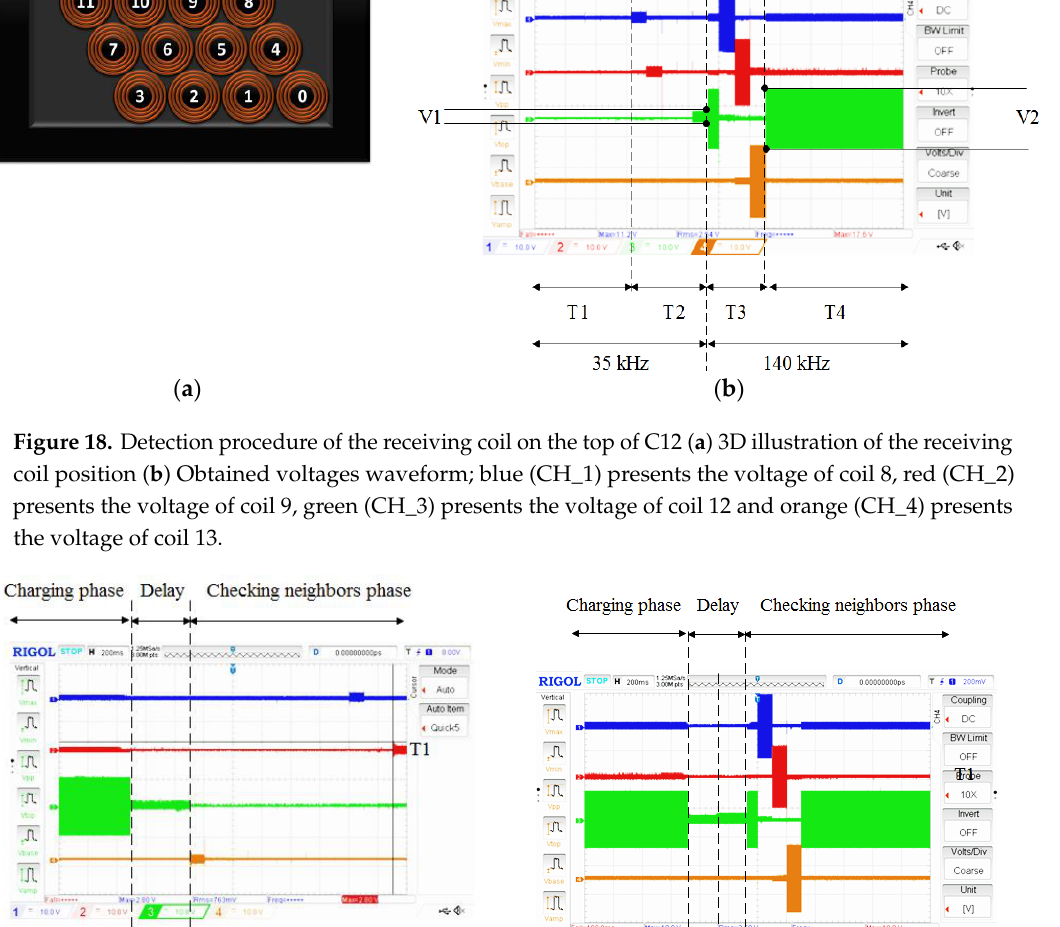
Figure 19. Voltages waveform ( a ) In case of the removing of the WSN ( b ) In case of perturbation of the WSN position; blue (CH_1) presents the voltage of coil 8, red (CH_2) presents the voltage of coil 9, green (CH_3) presents the voltage of coil 12 and orange (CH_4) presents the voltage of coil 13.